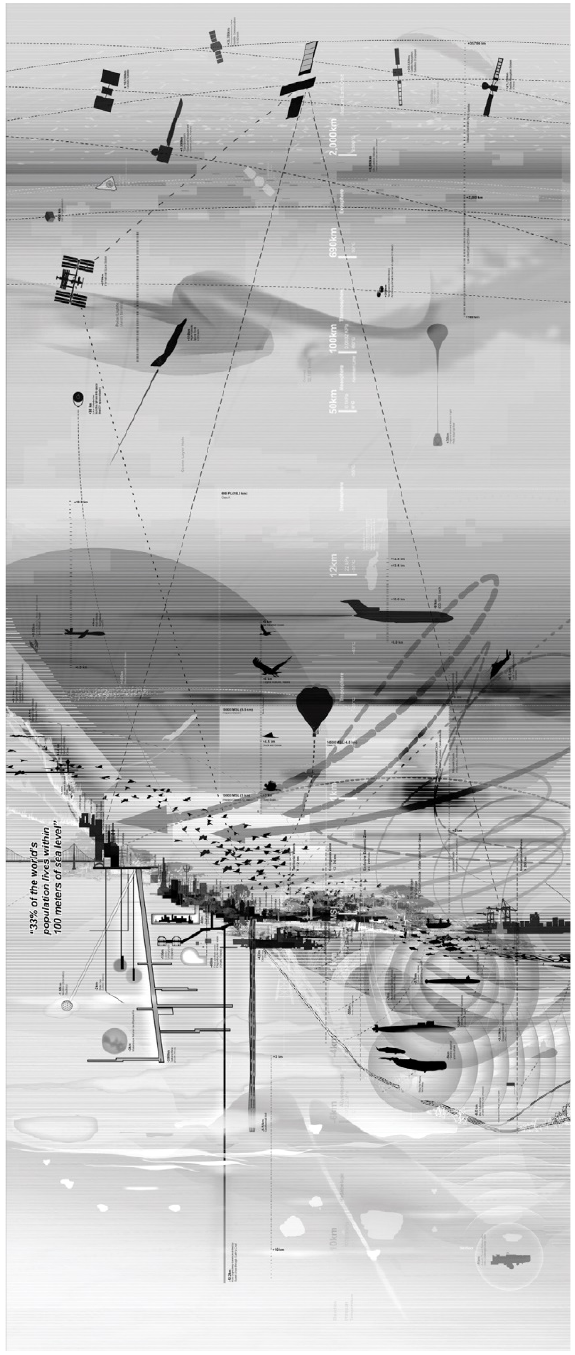
Figure 2. ‘Altitudes of Urbanization’ captures the many uses observed today in the urban volume, but it would be a mistake to presume that this is an exhaustive account of what the volume could be (Bélanger, 2016, p.